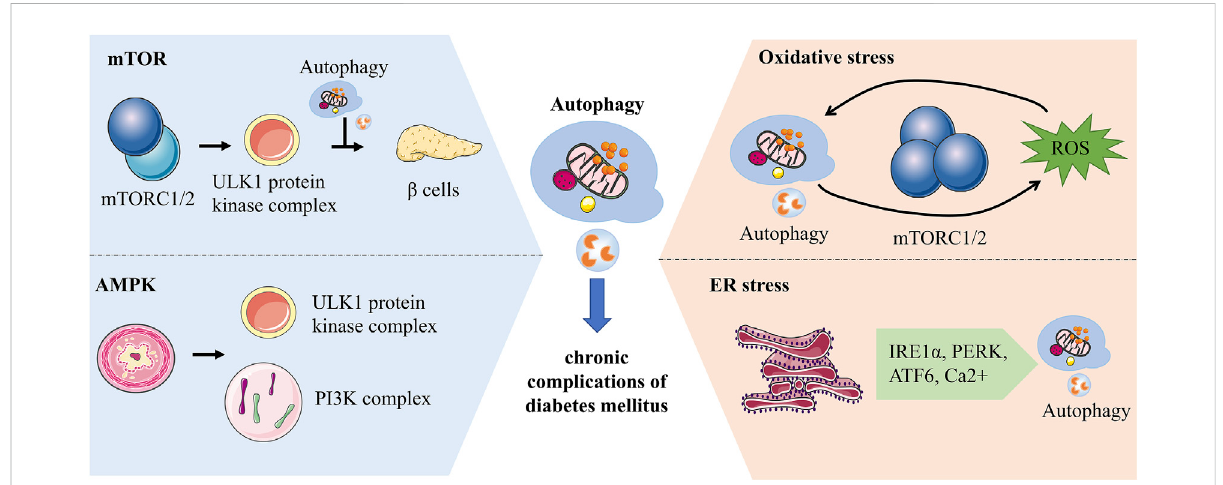
FIGURE 3 Molecular mechanisms of autophagy associated with chronic complications of diabetes. mTORC1 regulates the initiation of autophagy by inhibiting the phosphorylation of the ULK1 complex and has a bidirectional effect on pancreatic β -cells. AMPK can impact autophagy by activating phosphorylationofULK1orregulatingthePI3Kcomplex.AutophagyandROScanbemediatedbyeachother.ROSactivatesautophagybyincreasing beclin-1 expression and over-suppressing mTORC1, while autophagy can maintain ROS levels by clearing mitochondria. ER is an essential site of protein folding, while ER stress-mediated autophagy is associated with IRE1 α , PERK, ATF6 and Ca 2+ signaling